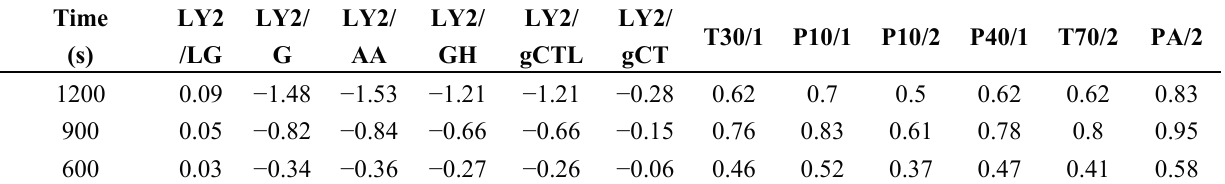
Table 4. The response intensity of sensors for different